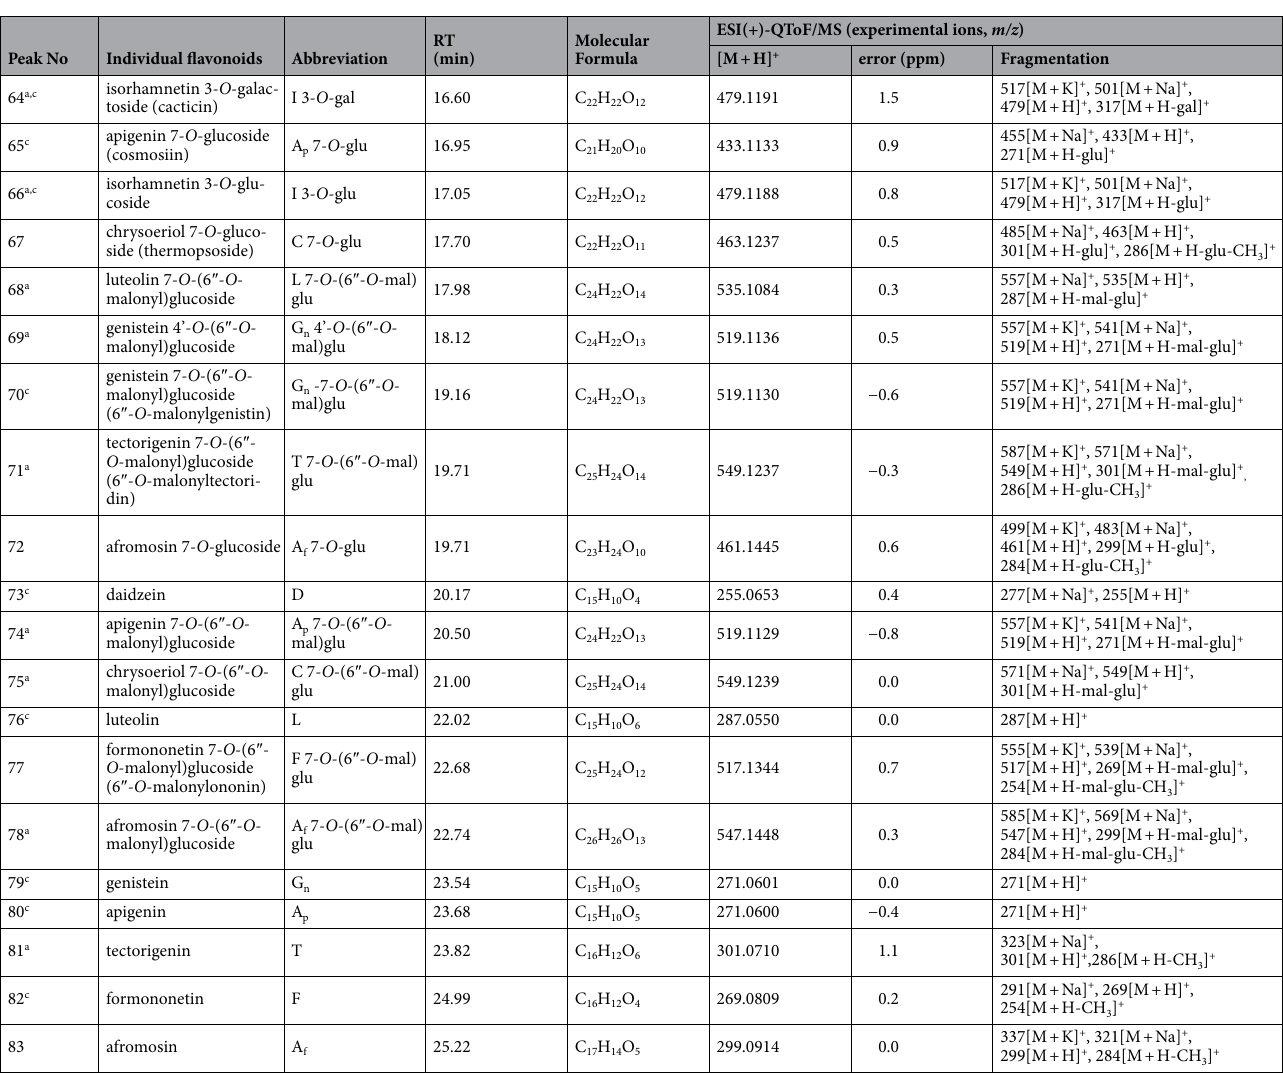
Table 1. Characterization of eighty-three flavonoid derivatives from young leaves of 21 soybean cultivars using UPLC-DAD-QToF/MS. All samples analyzed in positive ESI-ionization mode ( m/z [M + H] + ) of ToF– MS; [M + Na] + and [M + K] + adduct ions presented. Each peak was tentatively determined by comparing elution order, MS fragmentation and NMR confirmation presented in constructed library. RT = retention time; DME = dimethyl ester; A f = afromosin; A p = apigenin; C = chrysoeriol; D = daidzein; F = formononetin; G n = genistein; G y = glycitein; I = isorhamnetin; K = kaempferol; L = luteolin; Q = quercetin; T = tectorigenin; api = apiose (132 Da); gal = galactose (162 Da); glu = glucose (162 Da); rham = rhamnose (146 Da); mal = malonyl (86 Da). a, new flavonoid in soybean leaves; b, newly named; c, further confirmed in comparison with authentic similar cultivars ( SL s 6, 9 and 14) with Daewon kong ( SL 2, yellow) and consistent with deglycosidic patterns of peaks 6 and 7 14–17,20,23,25 . Especially, two di -glycosides related to peaks 16 and 21 , ‘K 3- O -(2 ″ - O -glu)gal’ (peak 26 ) and ‘K 3- O -(2 ″ - O -glu)glu’ (K 3- O -sop, peak 28 ) were only detected with large amount in SL s 7 and 21 14,15,17,24 . Additionally, new tri -glycosides, peaks 22 and 23 ( m/z 787[M + H] + , based on I ) were identified as ‘I 3- O -(2 ″ - O -glu-6 ″ - O -rham)gal’ (named as soyanin I ) and ‘I 3- O -(2 ″ - O -glu-6 ″ - O -rham)glu’ (named as soyanin II ) in mainly SL s 13 and 19, respectively. Twelve glycosides of glu 1 -gal 6 (peaks 18 , 30 and 44 ) / glu 1 -glu 6 ( gen , peaks 20 , 39 and 51 ) and rham 1 (glu (1) )- gal 2(6) (peaks 3 , 10 and 12 ) / rham 1 (glu (1) )-glu 2(6) (peaks 5 , 17 and 15 ) were closely related to each other and identified simultaneously in SL 4 unlike other cultivars (Supplementary Fig. S1). Among them, most glycosides were confirmed as new compounds except for K 3- O -(2 ″ - O -rham-6 ″ - O -glu)gal (peak 10 ) and K 3- O -(6 ″ - O - glu)glu (K 3- O -gen, peak 39 ) 5,14,23,25 . In special, ‘I 3- O -(2 ″ - O -rham-6 ″ - O -glu)gal’ (peak 12 ) and ‘I 3- O -(2 ″ - O - rham-6 ″ - O -glu)glu’ (peak 15 ) with m/z 787[M + H] + were tentatively determined as new tri - IG s through mass fragmented interpretation. Twelve di -glycosides of rham 1 -gal 6 ( rob , peaks 35 , 54 and 60 ) 5,14,19,21,23,25 / rham 1 -glu 6 ( rut , peaks 38 , 58 and 62 ) 5,14,19,21 and rham 1 -gal 2 (peaks 24 , 37 and 47 ) 14,16 / rham 1 -glu 2 ( neo , peaks 25 , 43 and 55 ) were fragmented